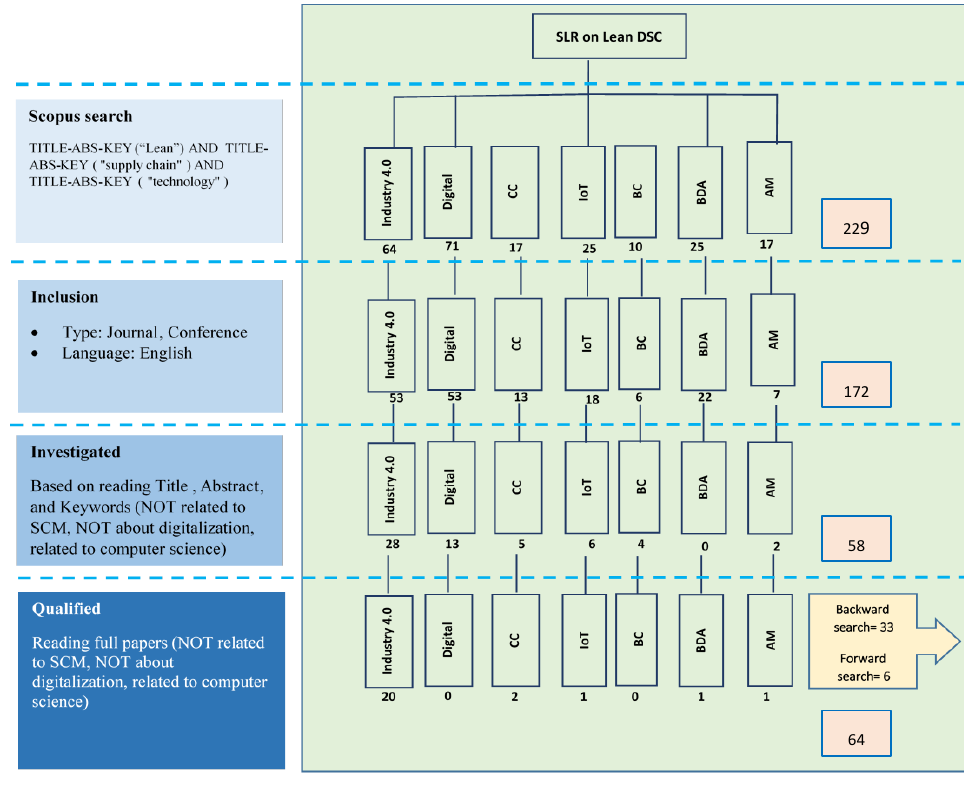
Figure 4. Results of SLR search .